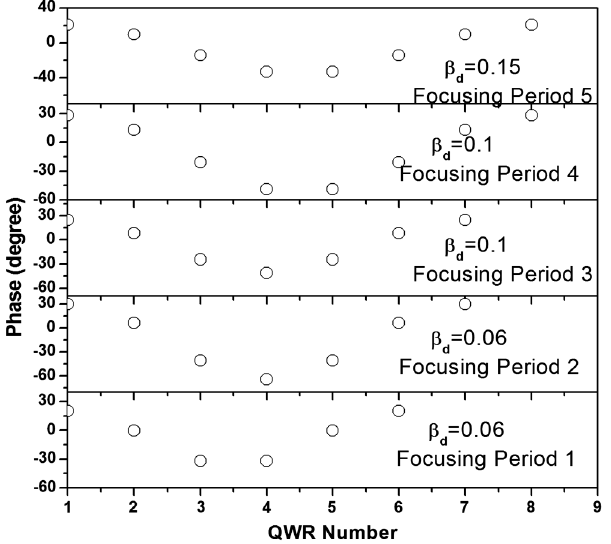
FIG. 4. Synchronous phase variation for the QWR in a par- ticular focusing period.